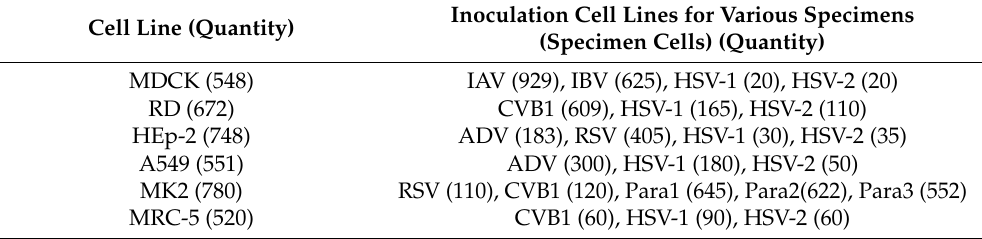
Table 1. Quantity of original cell microscope images. There are 6 cell lines and 10 viruses commonly encountered in our data collection. Inoculation Cell Lines for Various